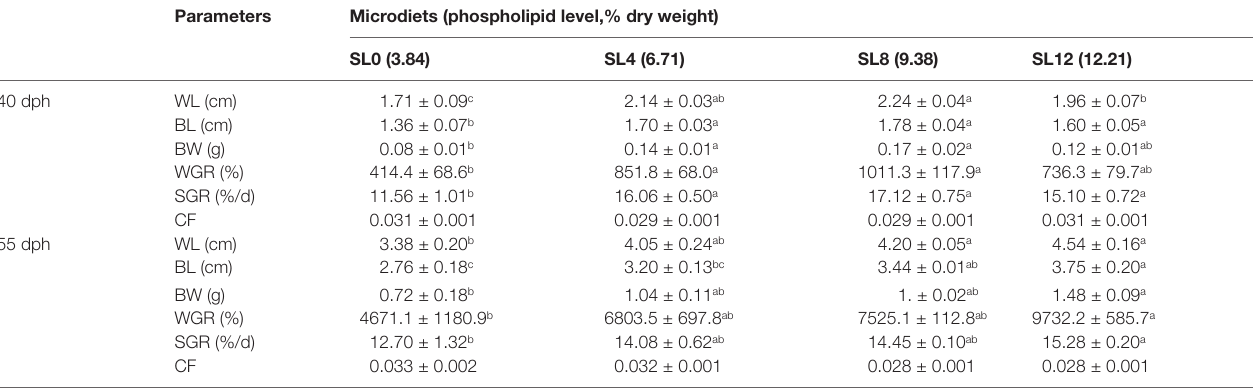
TABLE 3 | Growth performance and body indices of 40-dph and 55-dph rock bream larvae.